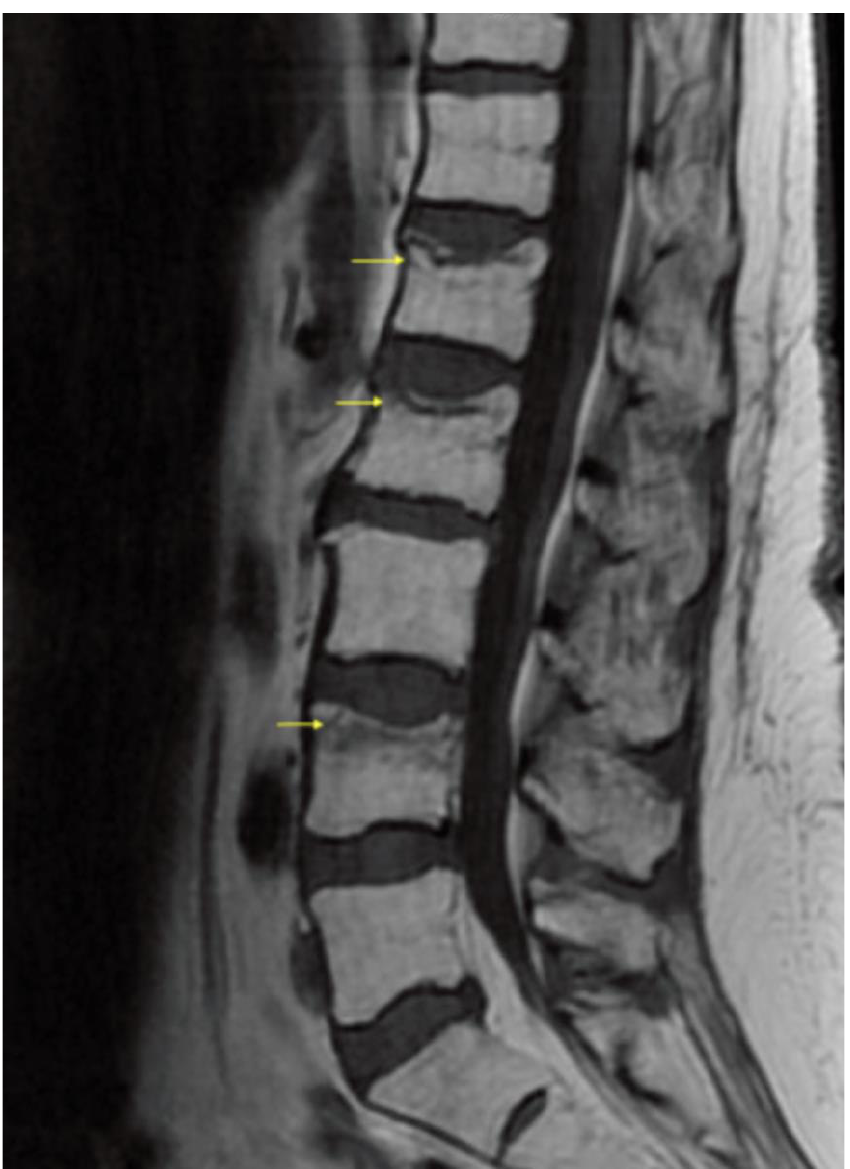
Figure 1. Lumbar spine magnetic resonance T1 image (MRI) with yellow arrows demonstrating superior endplate vertebral compression fractures of the L1, L2 and L4. In particular, the prominent bone marrow edema of the L4 vertebral endplate is consistent with an acute/subacute compression fracture.